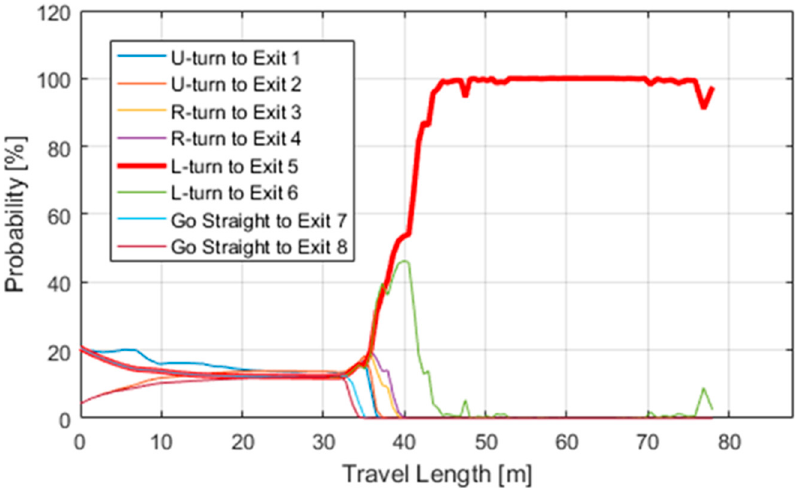
Figure 3. Mode probability update results for left turning case.